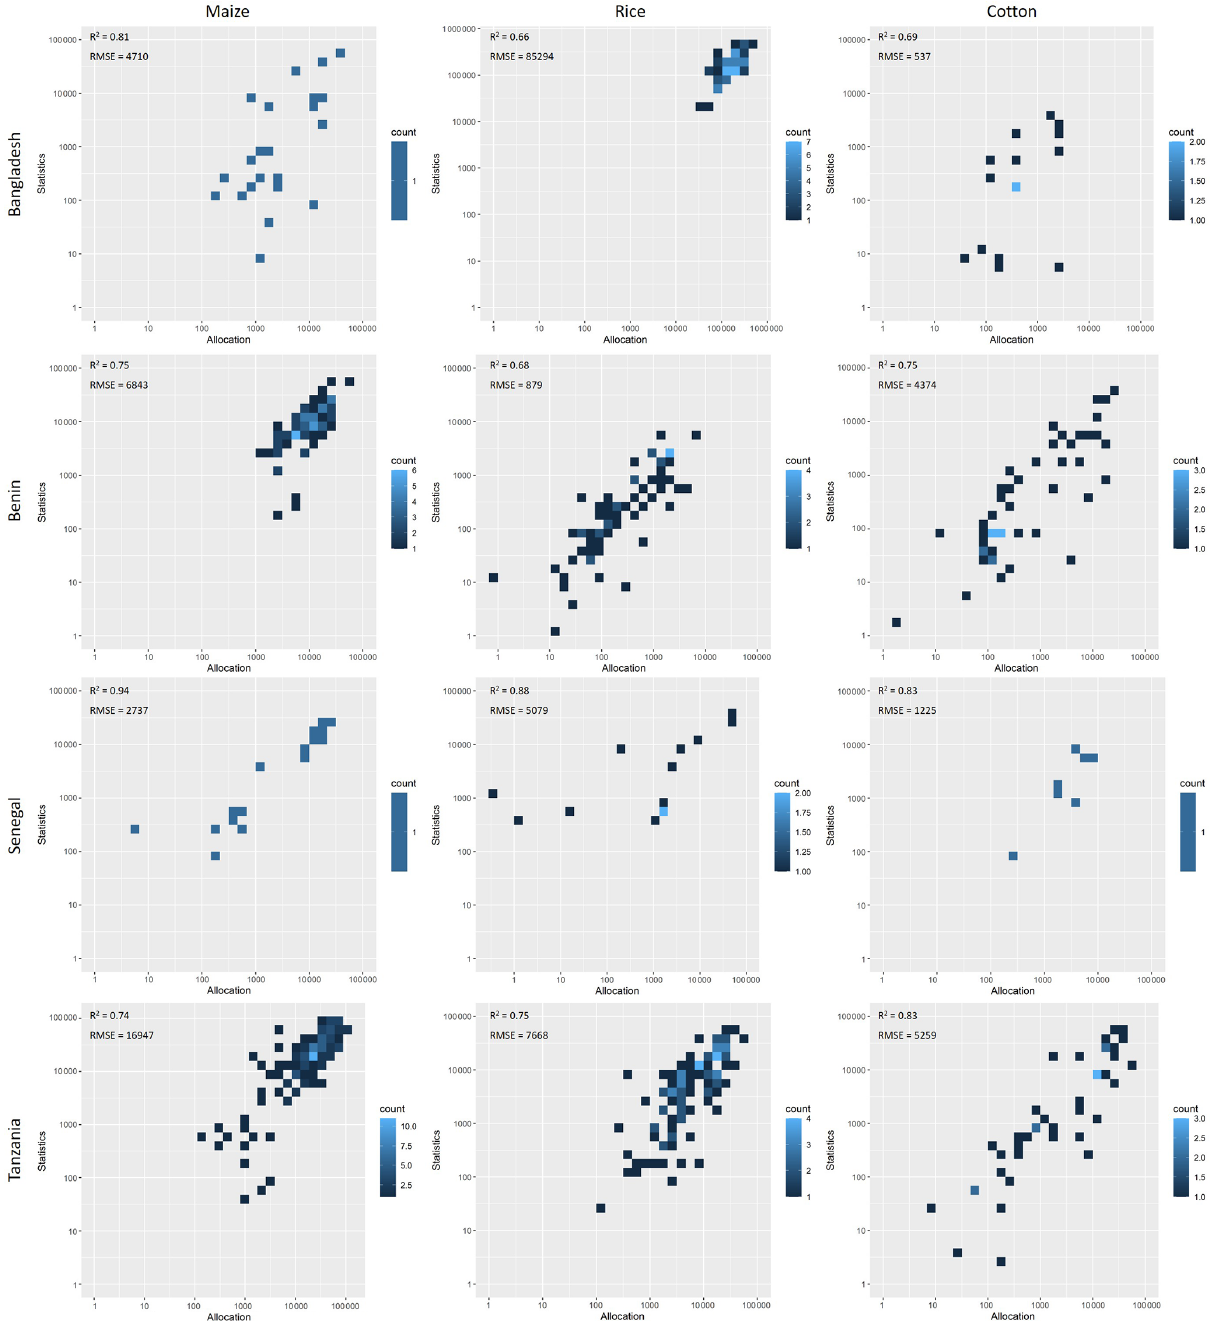
Figure 7. Comparison between the allocated crop area and statistics crop area at the ADM2 level in Bangladesh, Benin, Senegal, and Tanzania for maize, rice, and cotton (log–log scale plot; unit: